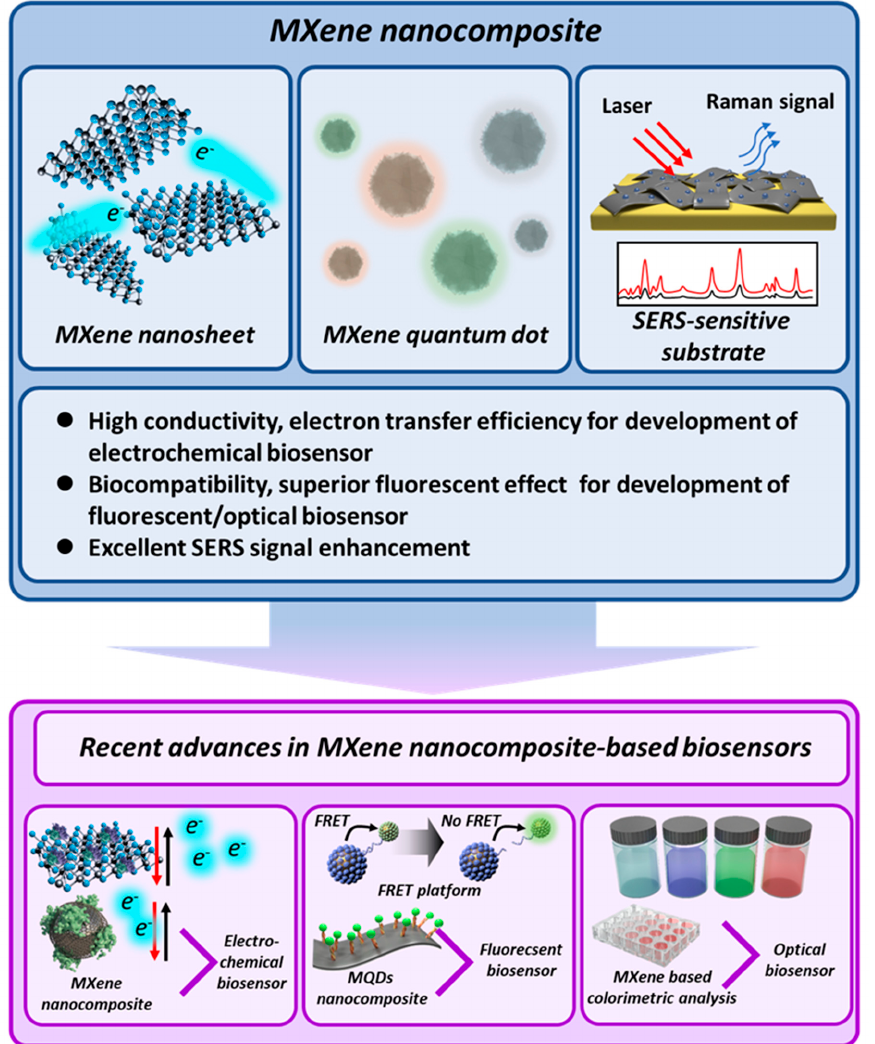
Figure 1. Recent advances in the development of advanced biosensors based on MXene